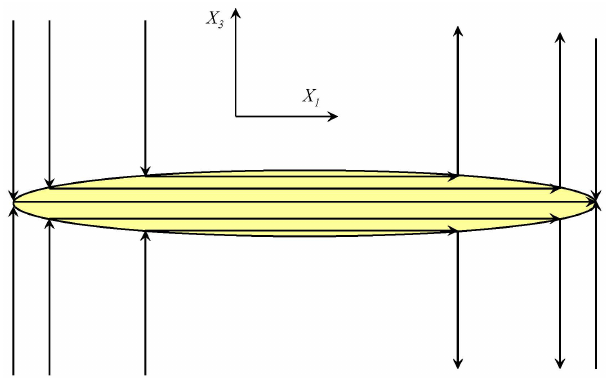
Fig. 2. Schematic diagram of current closure through the ellipsoidal trail (light-yellow shading). Vertical arrows depict ionospheric currents directed mainly along X 3 , while horizontal arrows depict trail currents which flow along X 1 .